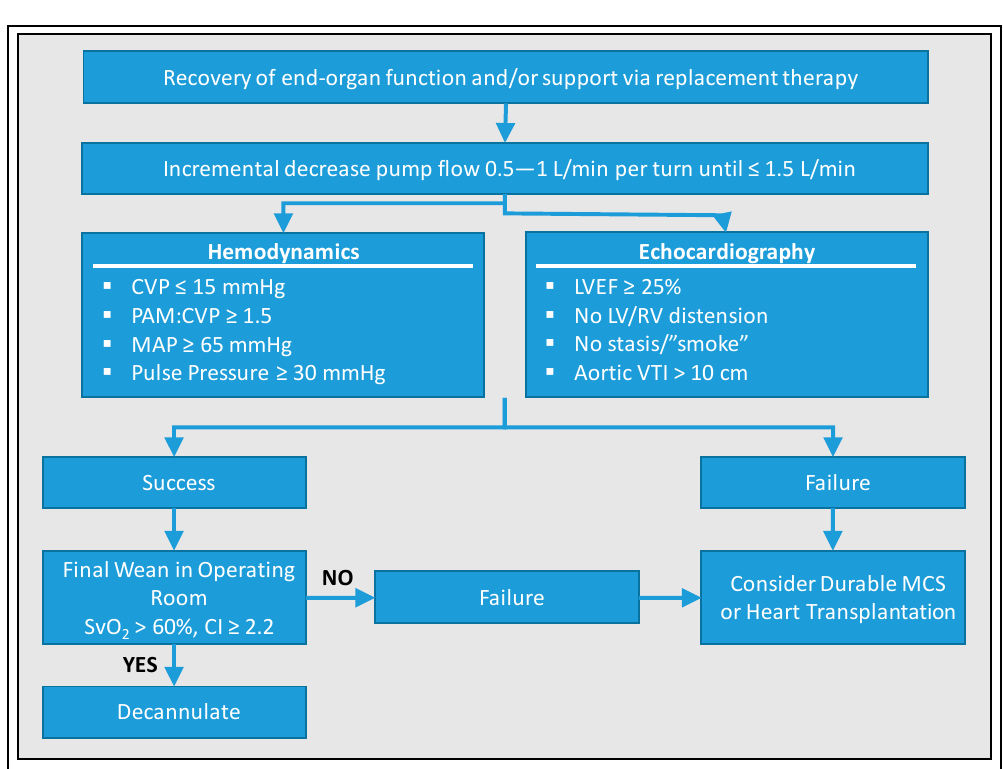
Figure 2. Standardized protocol for weaning from VA-ECMO according to Keebler et al. [18]. CVP, central venous pressure; PAM, pulmonary arterial mean pressure; MAP, mean arterial pressure; LVEF, left ventricular ejection fraction; LV, left ventricle; RV, right ventricle; VTI, velocity-time integral; SvO 2 , mixed venous oxygen saturation; CI, cardiac index; MCS, mechanical circulatory support.